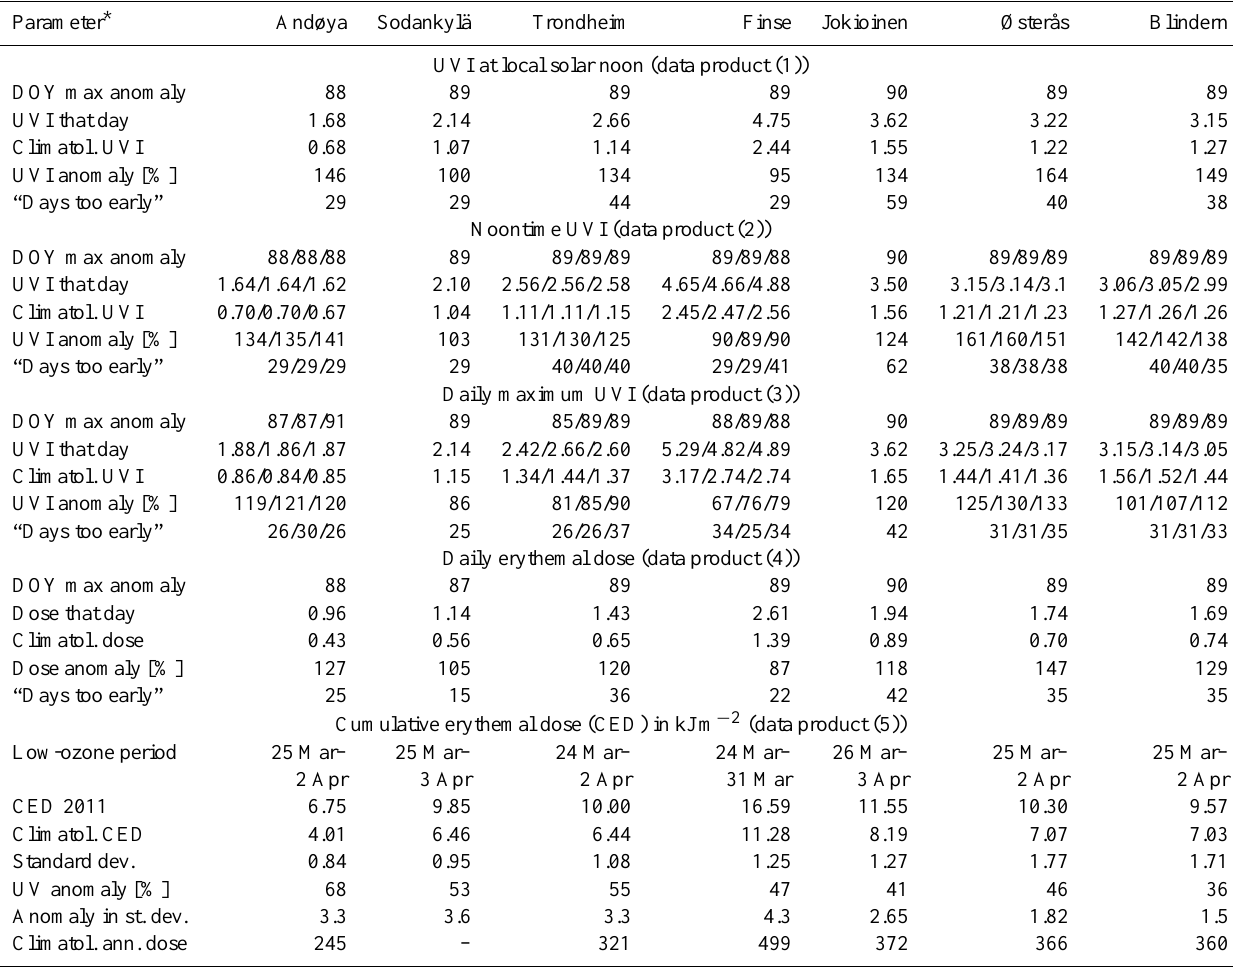
Table 5. Statistics for Scandinavian sites. For the Norwegian sites, statistics are provided for the native data set and subsampled data sets at 15 and 60min intervals, separated by a